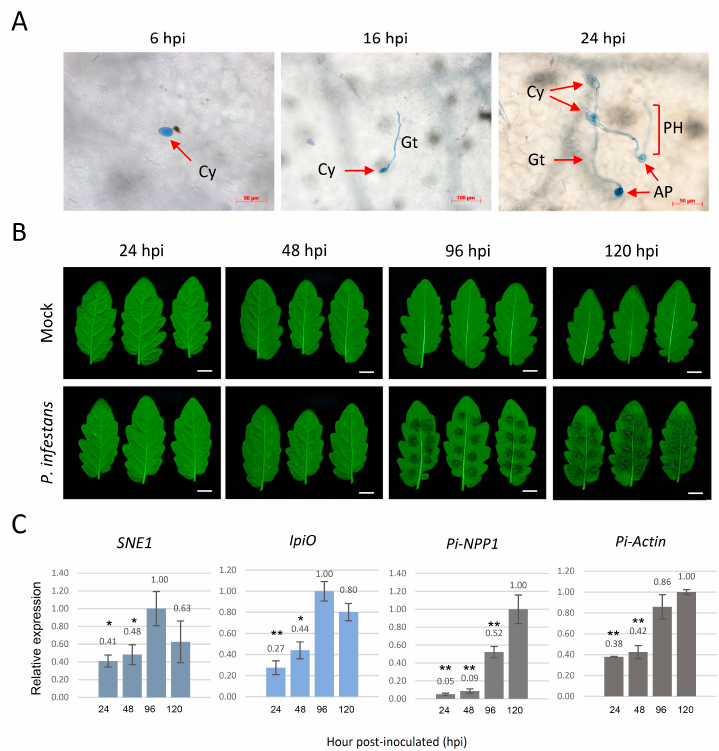
Figure 1. Inoculation of detached tomato leaflets by P. infestans. Detached leaflets of five-week-old tomato plants were inoculated with P. infestans by placing a 20 μ L drop of inoculum at eight spots on the abaxial surface of the leaflets. ( A ) Microscopic assessment of P. infestans developing on tomato leaflets at different time points post-inoculation after staining with trypan blue. At 6-h post-inoculation (hpi), the pathogens remained as cysts and started to germinate at 16 hpi. At 24 hpi, the primary hyphae (PH) were developed and the appressorium (Ap) structure was generated, indicating that the pathogen was ready to invade the plant cells. ( B ) Example leaflets showing P. infestans lesion development at 24, 48, 96 and 120 hpi. The white bar represents 1 cm. ( C ) Bar graphs showing the relative band intensity of reverse transcription-polymerase chain reaction (RT- PCR) products of P. infestans marker genes, SNE1 , IpiO , and PiNPP1.1 is shown in Figure S1. The RNA samples were extracted from tomato leaflets at 24, 48, 96, and 120 hpi. The relative transcript abundance is shown as a proportion of the most intense band in each gel image. The expression level of P. infestans actin was used to evaluate the biomass of the pathogen in tomato leaves. The expression levels of biotrophic stage markers ( SNE1 and IpiO ) were reduced after 96 hpi, and the necrotrophic stage marker ( PiNPP1.1 ) was continuously increased from 24 hpi to 120 hpi. The error bars are standard deviations and the graph represents the combined data from three biological replicates (n = 3). Differentially regulated genes with a p -value of less than 0.05 or a p -value of less than 0.01 are marked with single or double asterisks, respectively. Cy, cyst; Gt, germ tube; AP, appressorium; PH, primary